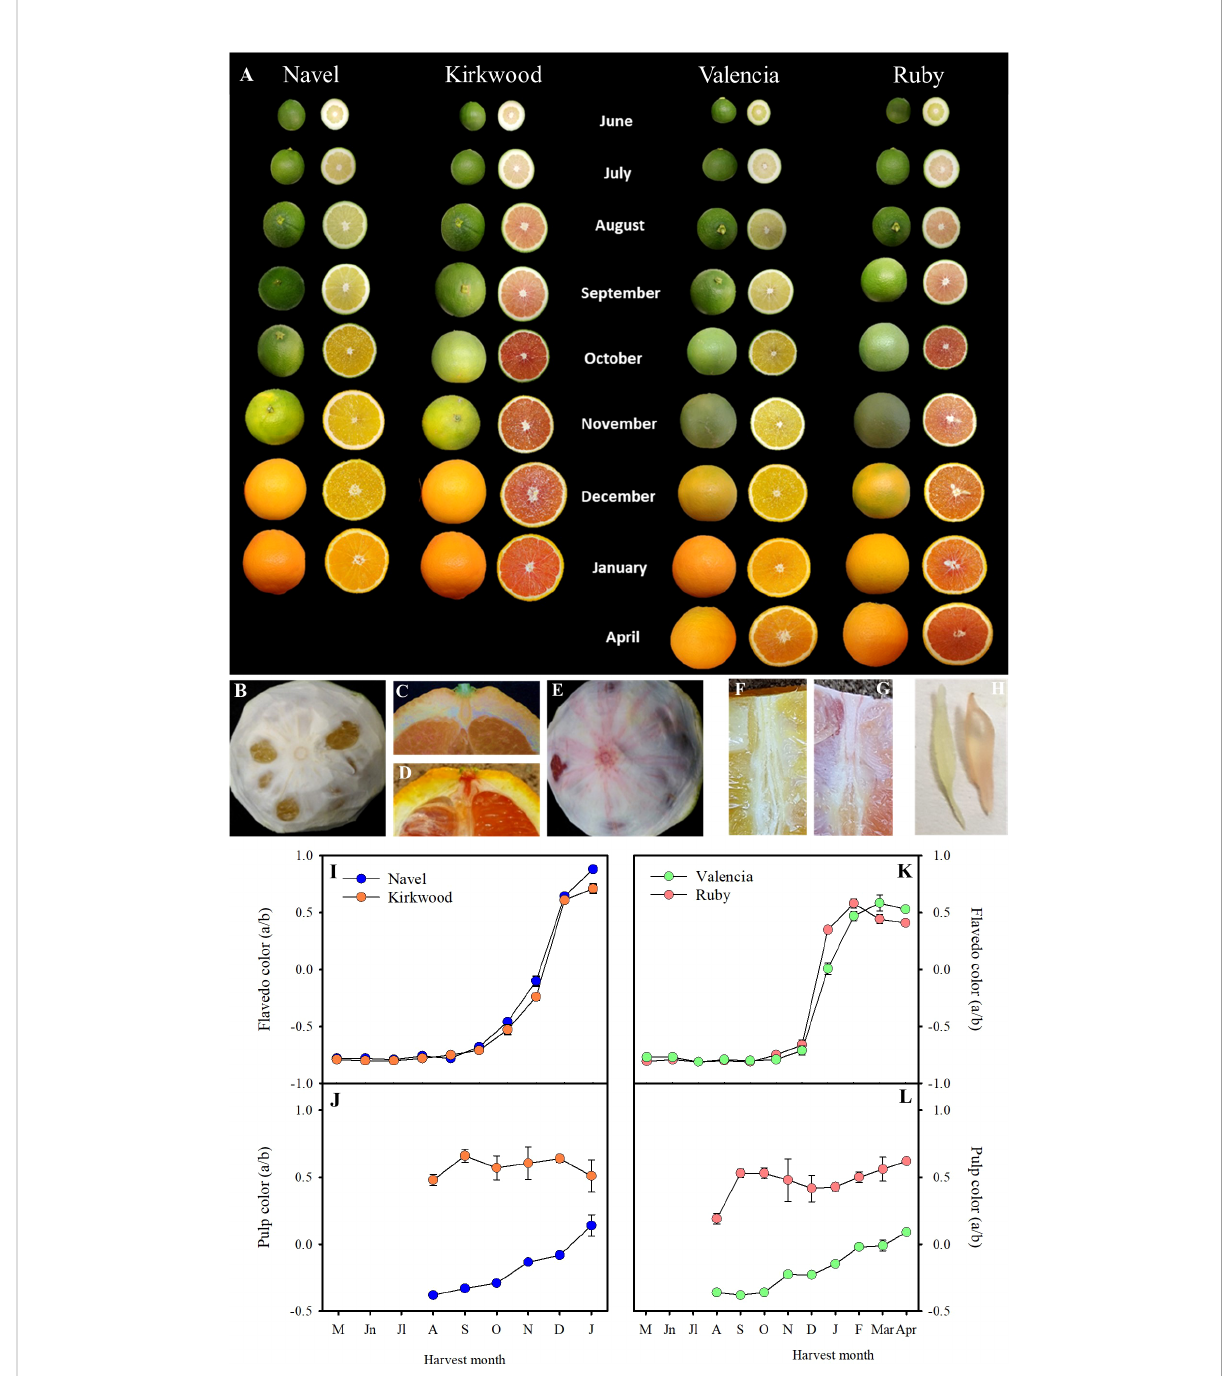
FIGURE 3 External and internal appearance of Navel, Kirkwood, Valencia and Ruby orange ( Citrus sinensis ) during fruit development and maturation, at the indicated harvest month. Fruits were harvested in the season 2018/2019, from an orchard located in Fundacio ́ n ANECOOP (Museros, Valencia), Spain (A) . Mature fruits of Valencia (B) and Ruby (E) oranges, in which the external fl avedo has been removed to see the color and the veins of the internal albedo layer. Longitudinal sections of the upper side of Valencia (C) and Ruby (D) oranges showing the notch of the peduncle and calix. Longitudinal section of the pulp of Valencia (F) and Ruby (G) oranges showing colour of the pulp and the central axis. Juice vesicle of Valencia (left) and Ruby (right) (H) . Evolution of the colour of the fl avedo (I, K) and pulp (J, L) of Navel and Kirkwood, and Valencia and Ruby, respectively, during fruit development and maturation. Data are the means of 30 measurements ±